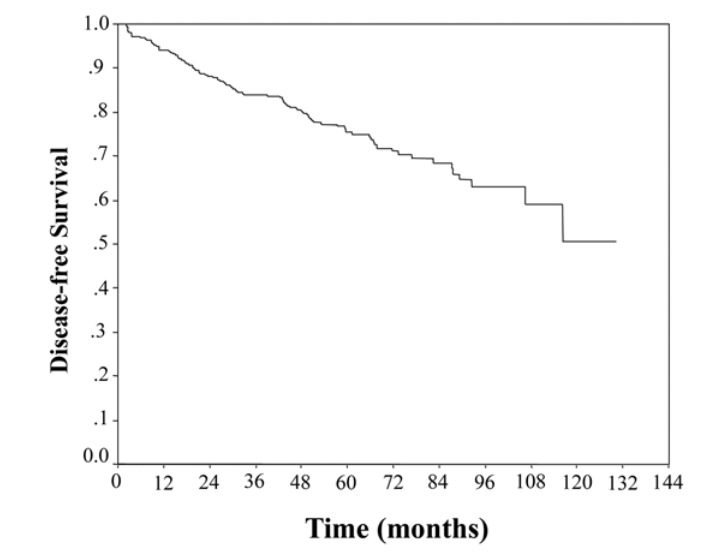
Figure 2 – Probability curve of overall biochemical recurrence-free